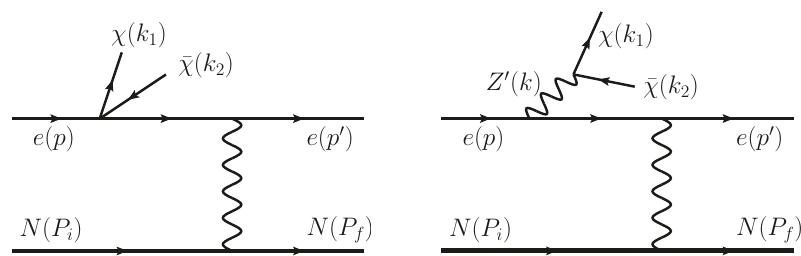
Figure 8 . Diagrams for the DM 2-to-4 production processes at NA64 for the EFT operators (left) and for the light mediator models (right). Only the initial state radiation processes are shown here. DM can also be radiated from the final state